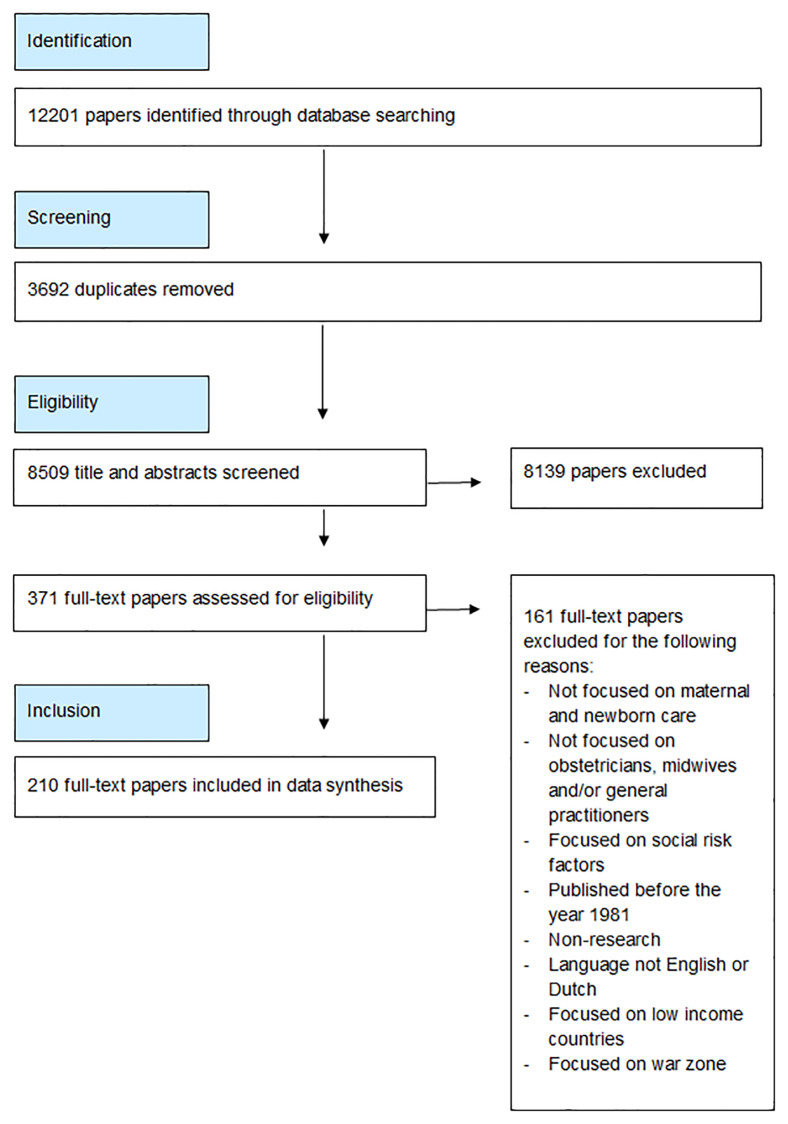
Study selection process [41].